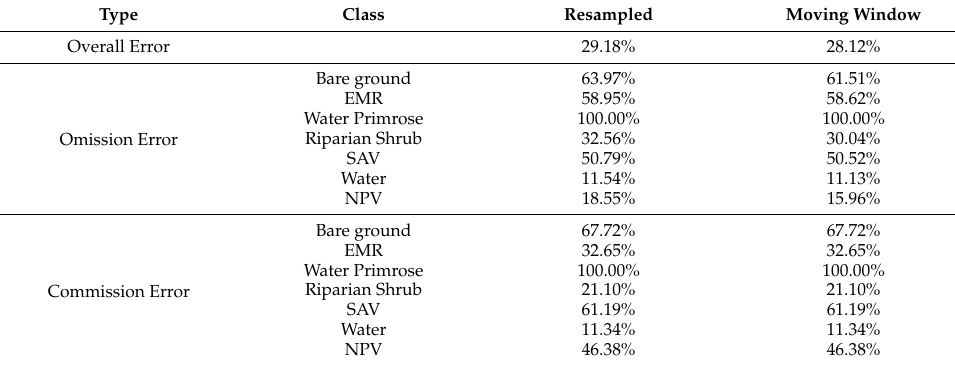
Table 6. Errors of omission and commission were calculated from the confusion matrix for the upscaled Nano maps using HyMap as a reference. Note: Absent classes had no occurrences in one of the